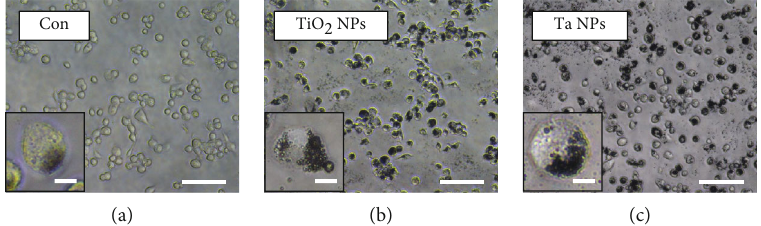
Figure 2: Bright- fi eld microscope images of THP-1-derived macrophages treated with TiO cultured in the presence of (a) standard culture medium (Con: control), (b) TiO 24h after exposure. Scale bar: 100 μ m (overview) and 10 μ m (enlarged